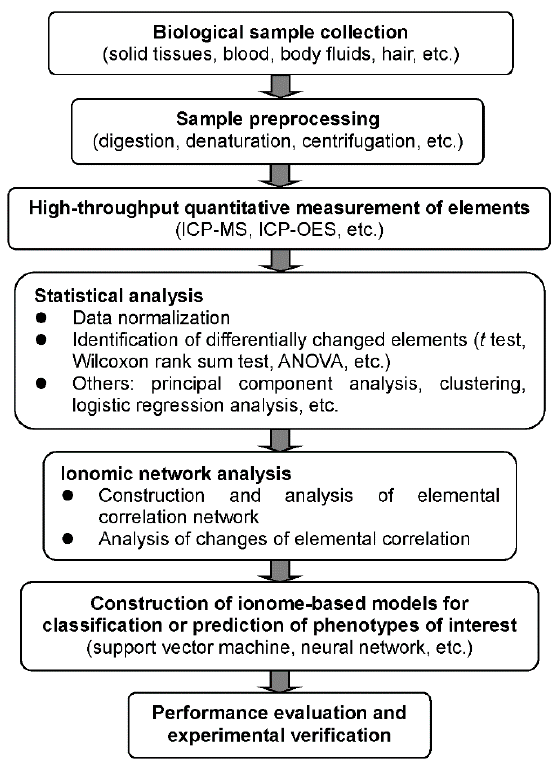
Figure 1. A schematic diagram for the measurement and bioinformatic analysis of the ionome.